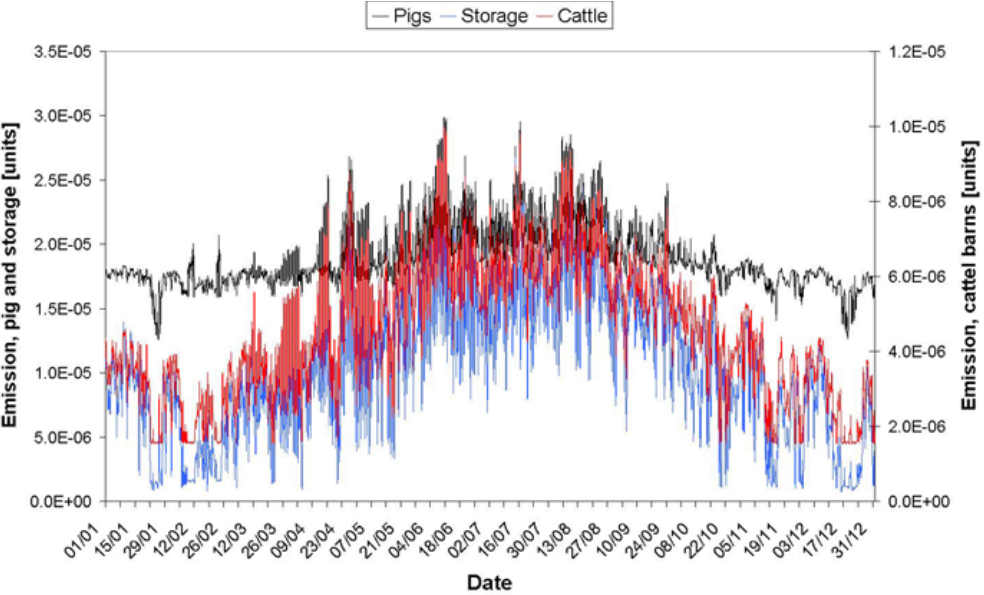
Fig. 3. Simulations of ammonia emission for open and isolated stables and manure storage using hourly meteorological input of temperature and wind speed. All times series were created by using meteorological data for the year the year 2007 and the emission model available at